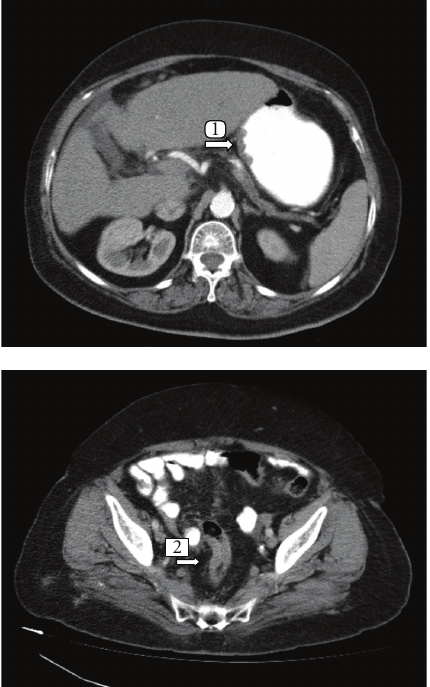
Figure 5: Evaluation of distant metastases by thorax and abdominal CT. No findings were detected in favor of additional metastatic foci in CT scans of thorax or abdomen other than thickening in the gastric wall and asymmetric thickening in the rectal wall. Arrow 1 indicates thickening in the gastric wall and arrow 2 indicates thickening in the rectal